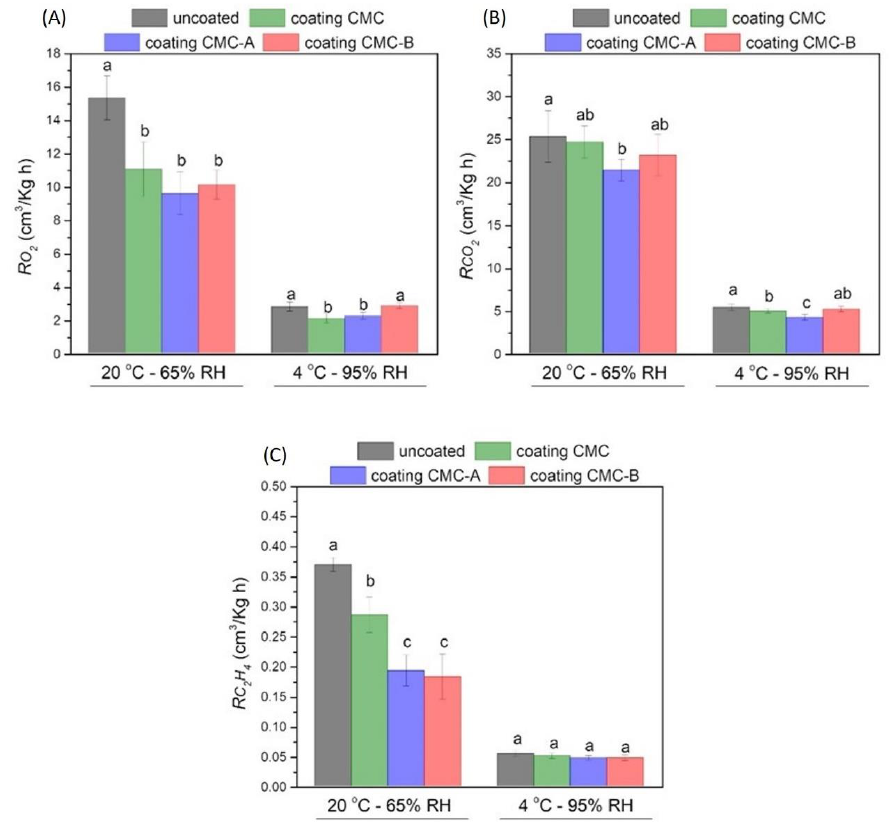
Figure 1. O 2 ( A ), CO 2 ( B ), and C 2 H 4 ( C ) transfer rates in fresh goldenberries at 20 °C and 65% RH and 4 °C and 95% RH. Results are expressed as mean ± standard deviation ( n = 6). Different letters within each temperature and RH group correspond to statistically different values for a 95% confidence level. Sample names correspond to the three treatments tested on fresh goldenberries: (i) coating CMC (CMC-based edible coating); (ii) coating CMC-A (CMC-based edible coating with SCG extracts rich in polysaccharides); and (iii) coating CMC-B (CMC-based edible coating with SCG extracts rich in polysaccharides and phenolic compounds encapsulated). Uncoated corresponds to fruits without coating.